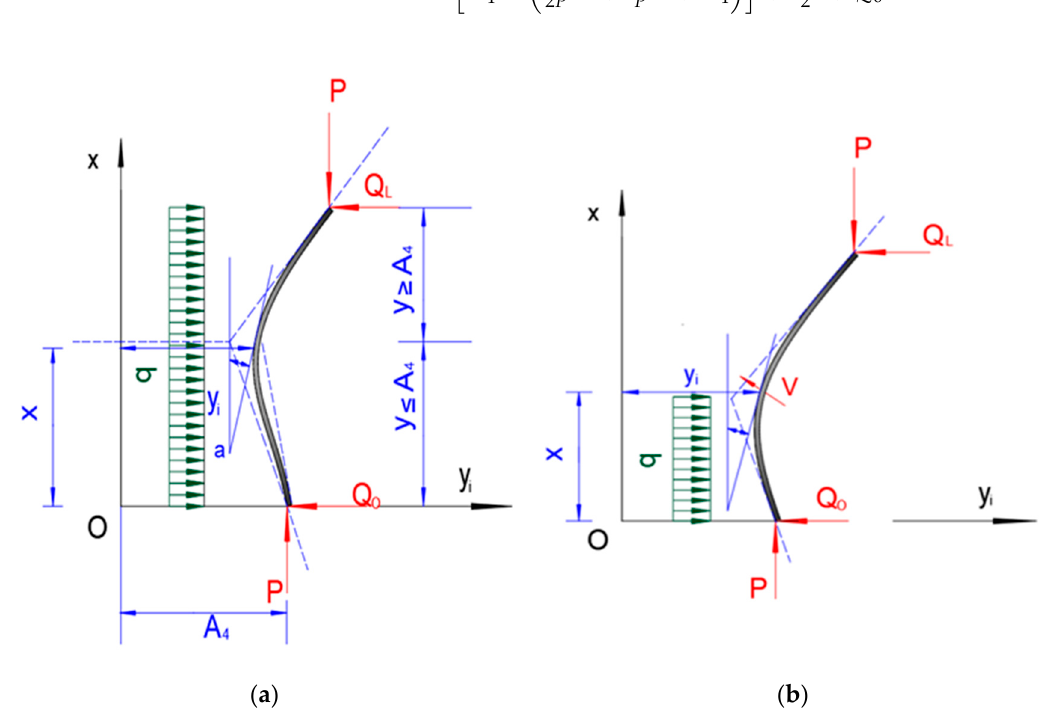
Figure 4. Schematic diagram of initial deflection curve of compression rod: ( a ) diagram of the relationship between the initial deflection curve and the load and ( b ) Diagram of shear force composition on the vertical section of initial deflection curve.